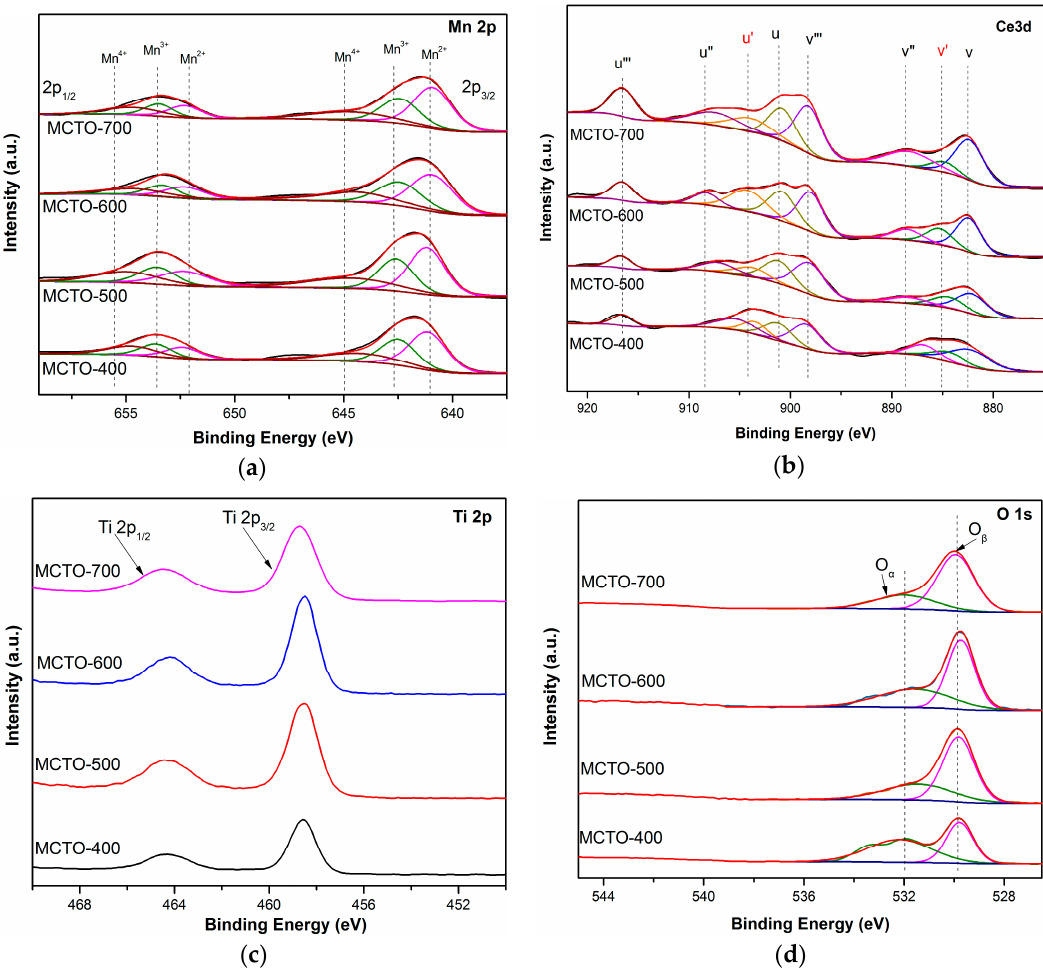
Figure 5. XPS spectra of the MCTO-400, MCTO-500, MCTO-600, and MCTO-700 catalysts: ( a ) Mn